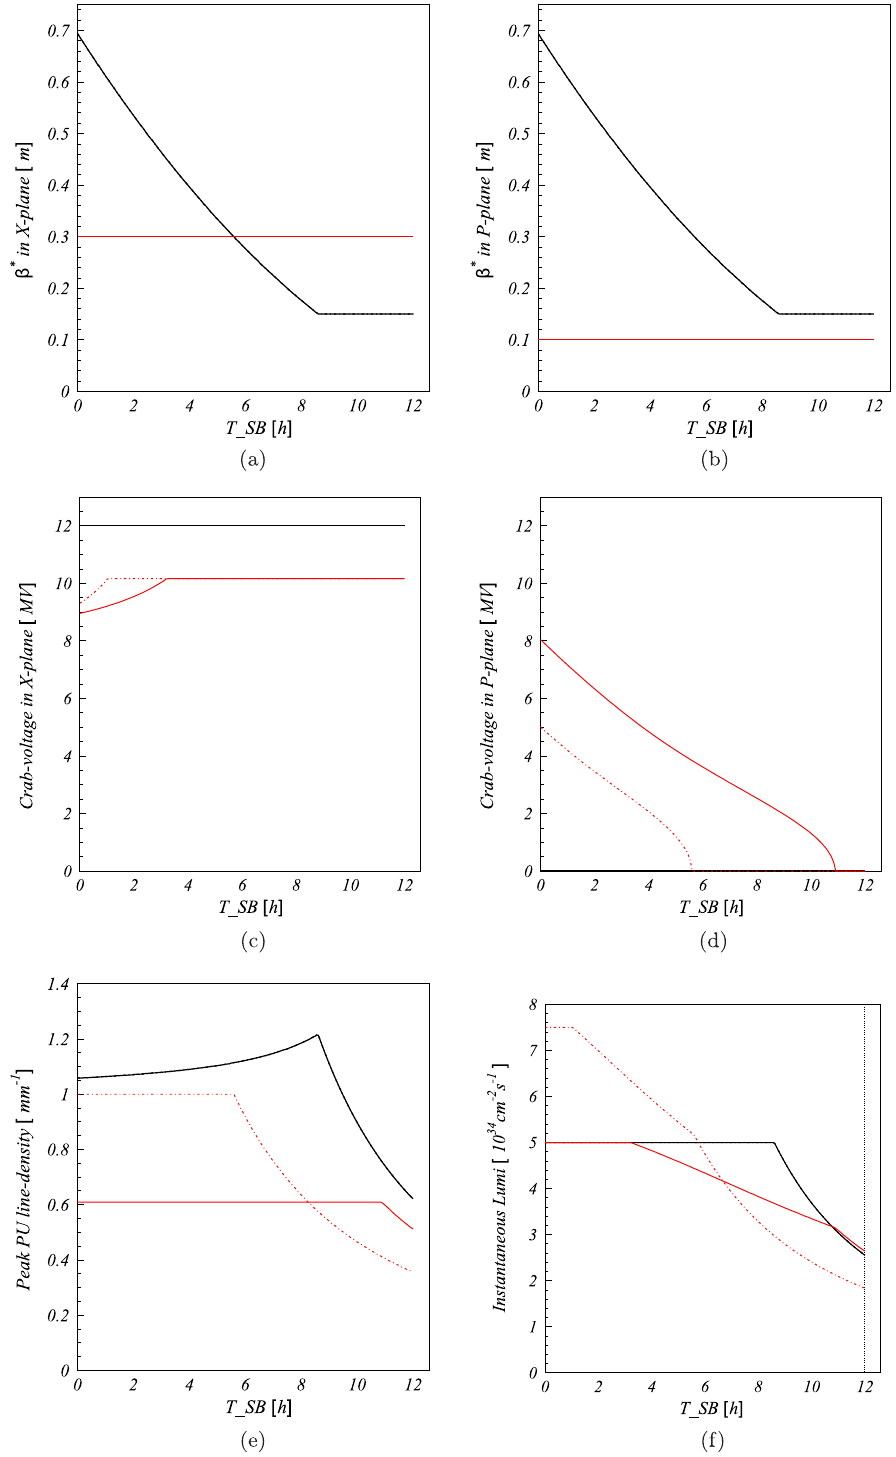
FIG. 7. Evolution of β (cid:1) (a – b) and crab-cavity voltage program (c – d) in stable beam (SB), and resulting profiles for the peak line PU density (e) and the instantaneous luminosity (f), for three possible HL-LHC running scenarios, namely: the baseline β (cid:1) leveling scenario (black solid lines) and a first crab-kissing scenario (red solid lines) corresponding to the cases a and c of Table III, respectively, and the same CK configuration but where the luminosity and the peak PU density are pushed up to L 0 ≤ 7 . 5 × 10 34 cm − 2 s − 1 ( μ ˆ μ ≤ 1 . 0 mm − 1 (red dotted-dashed lines). Any possible source of emittance growth is neglected in the above calculations. The beam z current decay is assumed to be dominated by the proton burn off due to the collisions in the two high luminosity insertions, assuming a ¼ 100 mb per total hadron cross section of σ tot